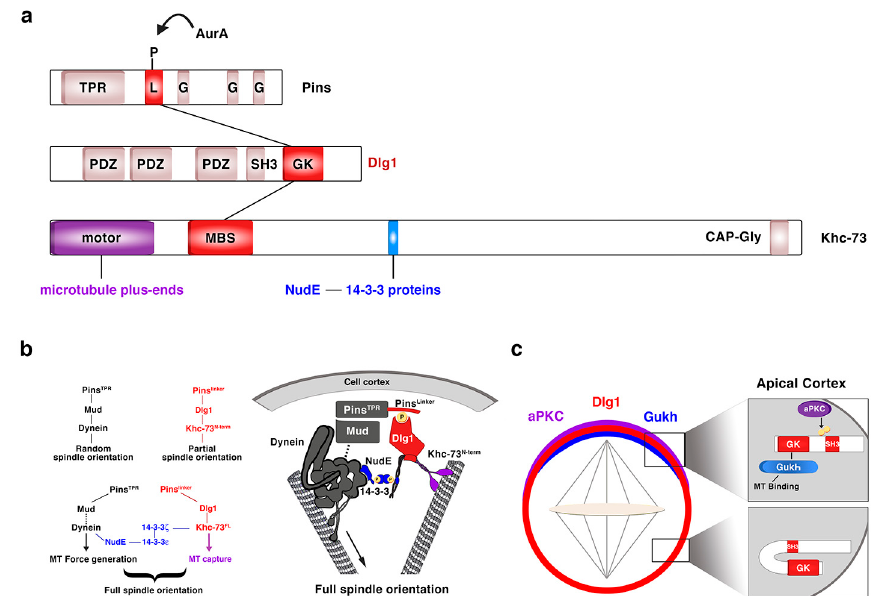
Figure 5. Dlg1 in asymmetric NB division. ( a ) Modular structure of the ACD regulators Pins, Dlg1 and Khc-73. The kinase AurA phosphorylates the linker domain (L) of Pins, and the GK domain of Dlg1 binds both this phosphorylated Pins Linker domain and the MBS motif of Khc-73. This kinase binds astral microtubule plus-ends through its motor domain and 14-3-3 ζ protein through a 14-3-3 binding motif present at the C-terminal stalk, between the MBS and the CAP-Gly motif. TPR: TetratricoPeptide Repeat; L: Linker; G: GoLoco; PDZ: PSD-95 / Dlg / ZO-1; SH3: Src Homology 3; GK: Guanylate Kinase; MBS: Maguk Binding Stalk; CAP-Gly: Cytoskeleton Associated Proteins-Glycine-rich. ( b ) The two Pins-mediated pathways that orientate the mitotic spindle are connected through a NudE-14-3-3 protein bridge, which binds the two motor proteins involved in each of those pathways. NudE binds the motor Dynein and 14-3-3 ε , which forms a heterodimer with 14-3-3 ζ that in turn interacts with the motor Khc-73 (adapted from Lu and Prehoda, Dev Cell, 2013). ( c ) aPKC phosphorylates the SH3 domain of Dlg1 releasing an intramolecular inhibitory binding between SH3 and GK domains. GK can then bind the microtubule interactor protein Gukh, which contributes to the proper orientation of the mitotic spindle (adapted from Golub et al., eLIFE,